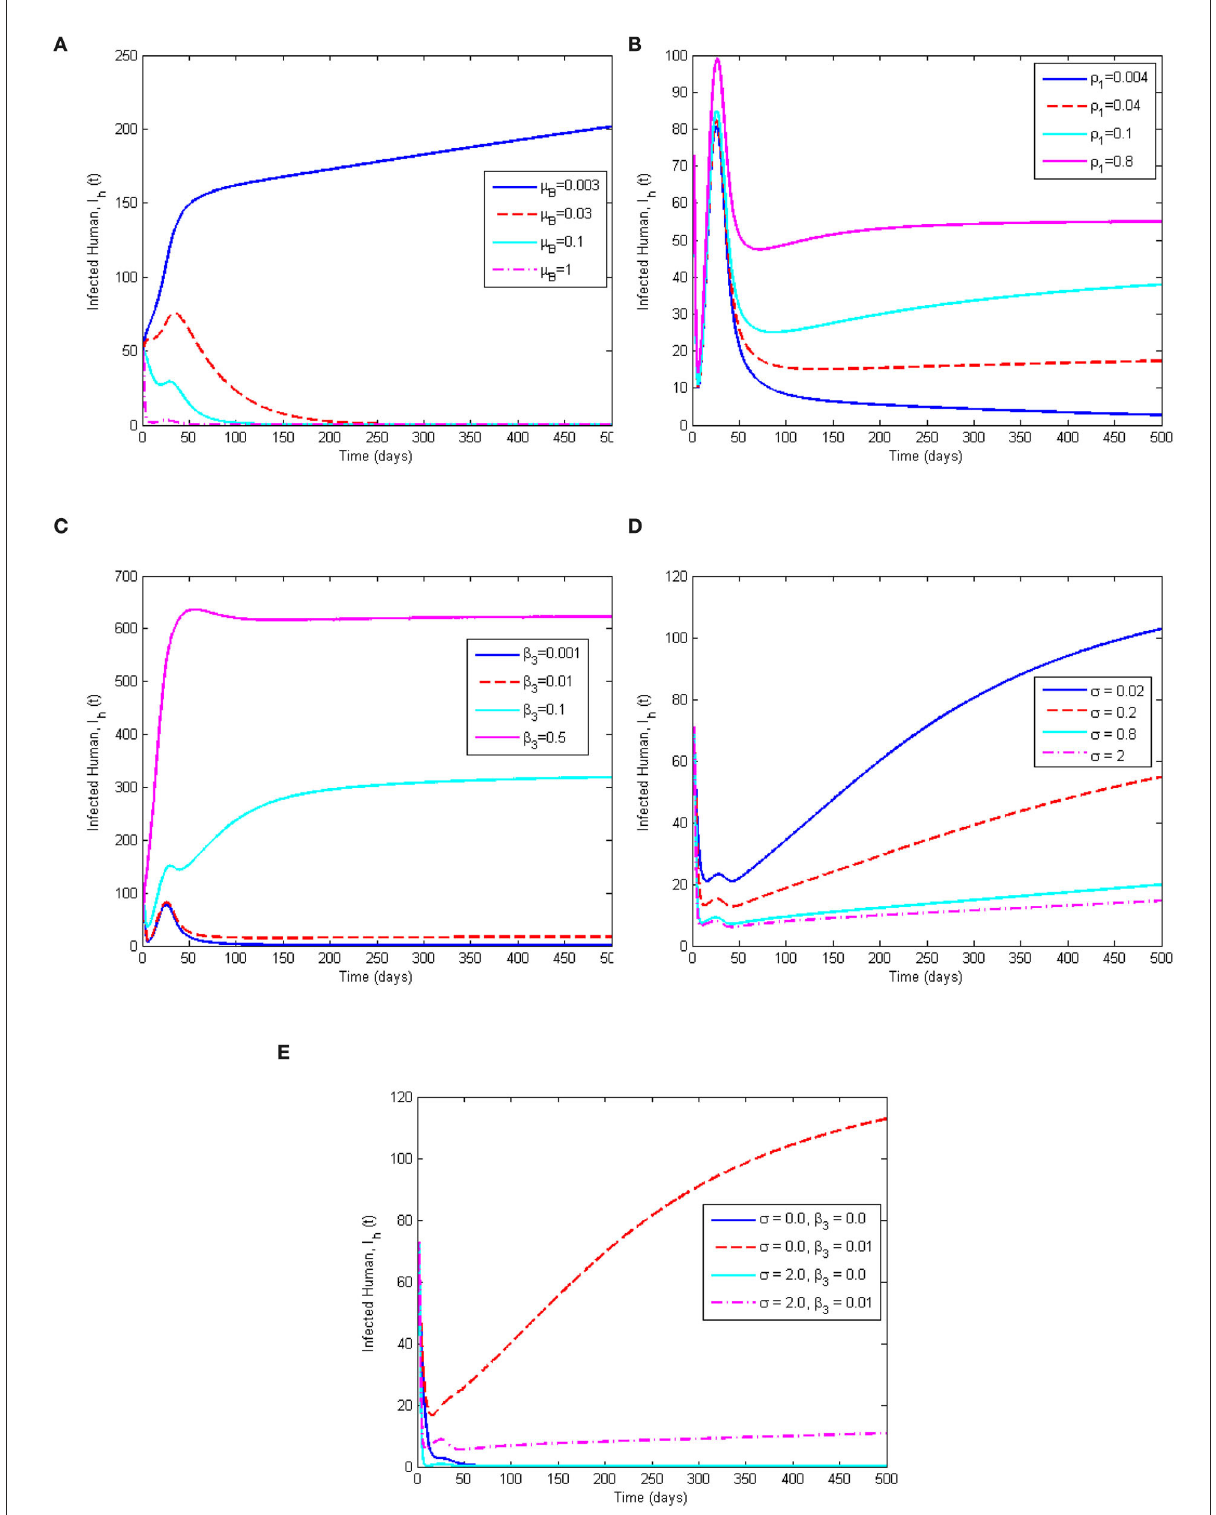
FIGURE7 Simulation results showing (A) the effect of µ B on the infected human population, (B) the effect of ρ 1 on the infected human population, (C) the effect of β 3 on the infected human population, (D) the effect of quarantine rate ( σ ) on the infected human population, and (E) the combined effect of σ and the environmental transmission rate β 3 on the infected human population. The parameter values used are given in Table